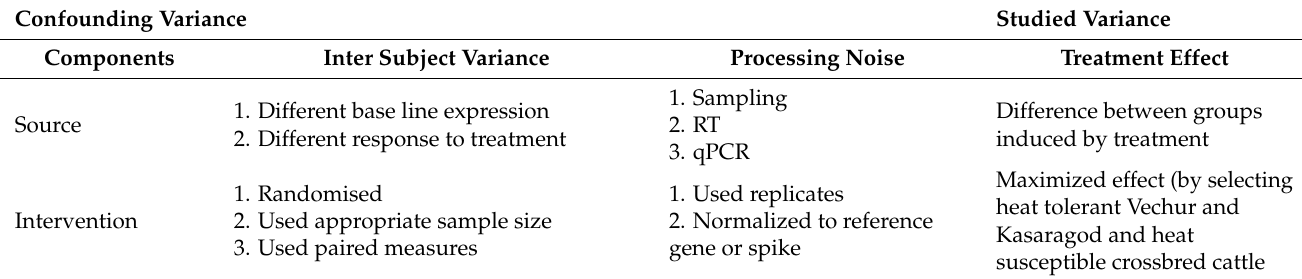
Table 1. Distribution of variance components followed in the gene expression study [39]. Confounding Variance Studied